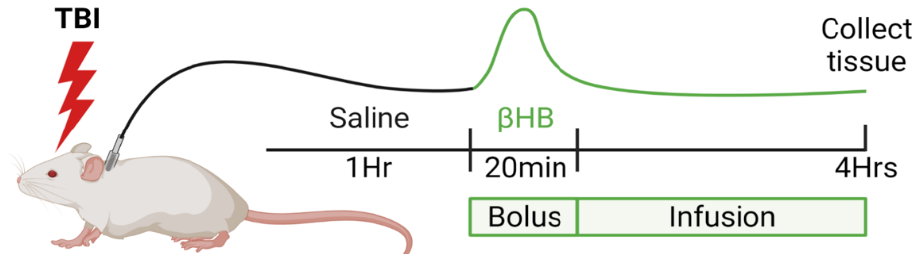
Figure 1. Experimental paradigm of infusion of β -hydroxybutyrate (BHB) following sham or TBI surgery. Figure was created using BioRender.com (accessed on 26 May 2022).